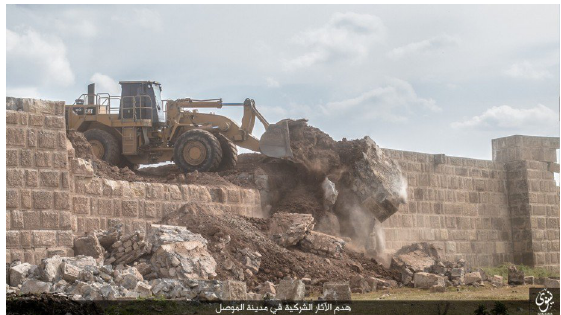
Figure 28. Heavy vehicle during the destruction of Adad Gate—April 2016